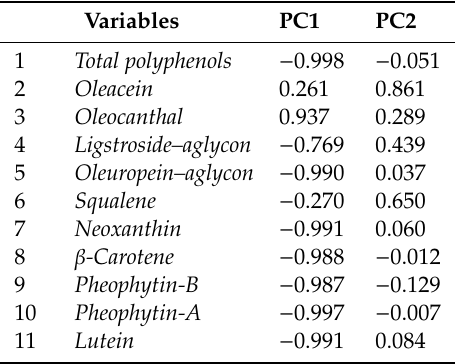
Table 3. X-loadings for the variables with respect to the principal components 1 and